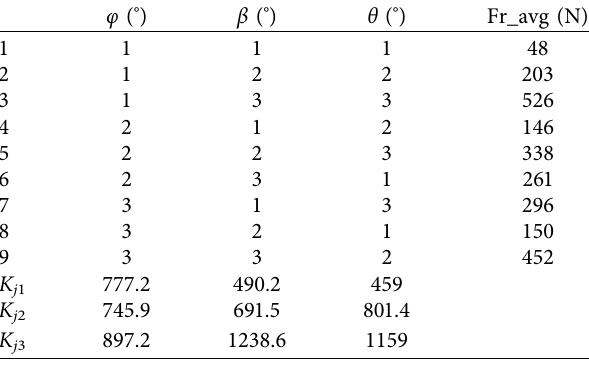
Table 3: Orthogonal experimental